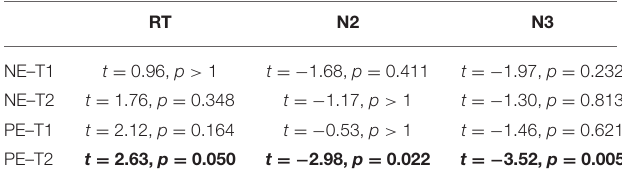
TABLE 2 | Paired t -test results for the Nx4 effect (placebo vs. Nx4) on the reaction time (RT) and N2 and N3 amplitudes of ERP components at tone 1 (T1) and tone 2 (T2) presented with negative (NE) and positive (PE) emotional